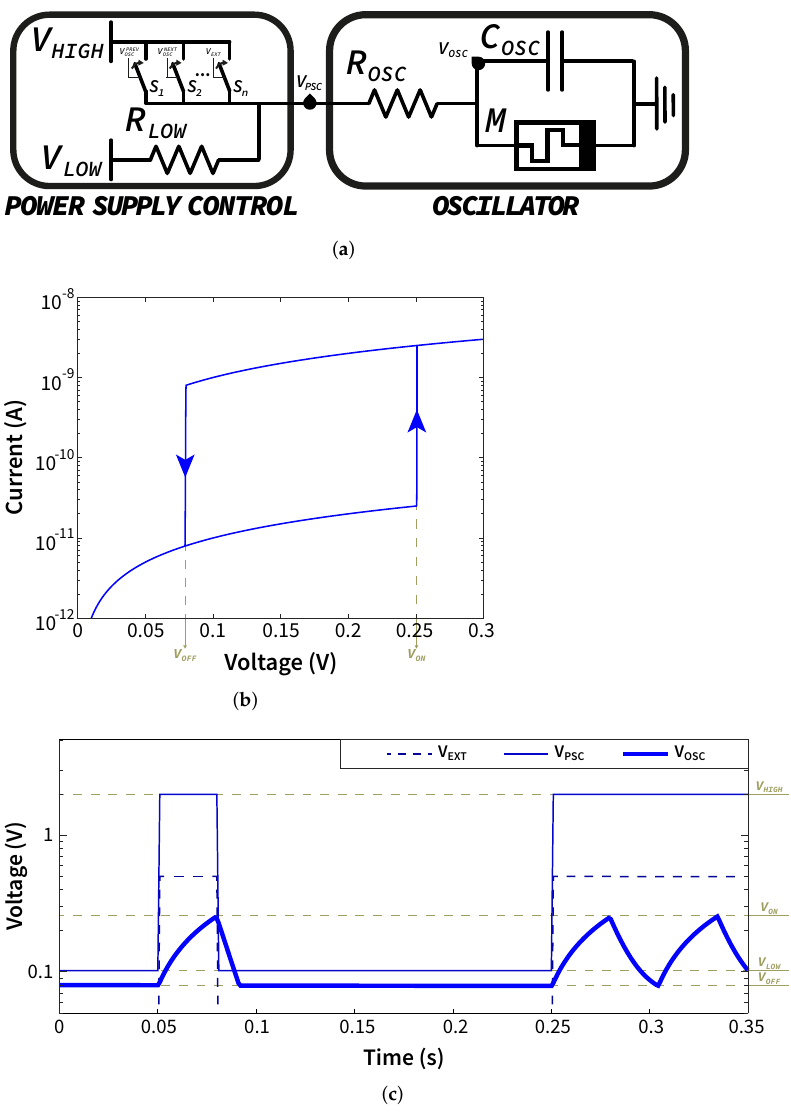
Figure 20. ( a ) MemRC cell circuit schematic composed of the power supply control ( left ) and the oscillator ( right ). ( b ) I - V characteristic of the memristor model. ( c ) MemRC cell